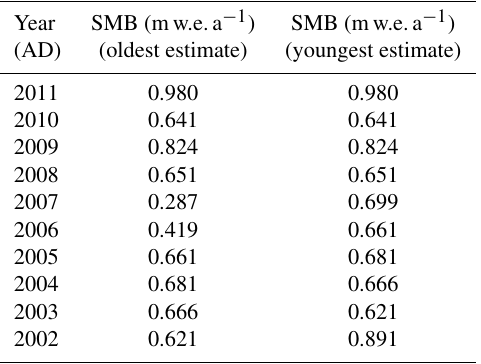
Table 2. SMB of the last 10 years from IC12 ice core (oldest and youngest estimates; see text for